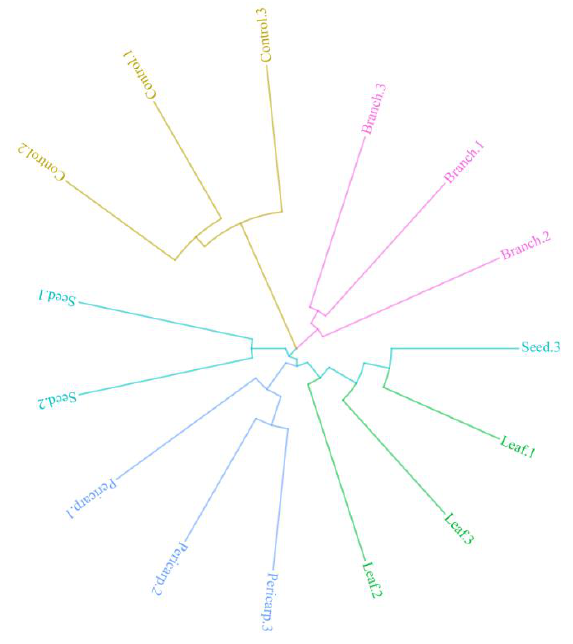
Figure 7. UPGMA sample similarity clustering results.